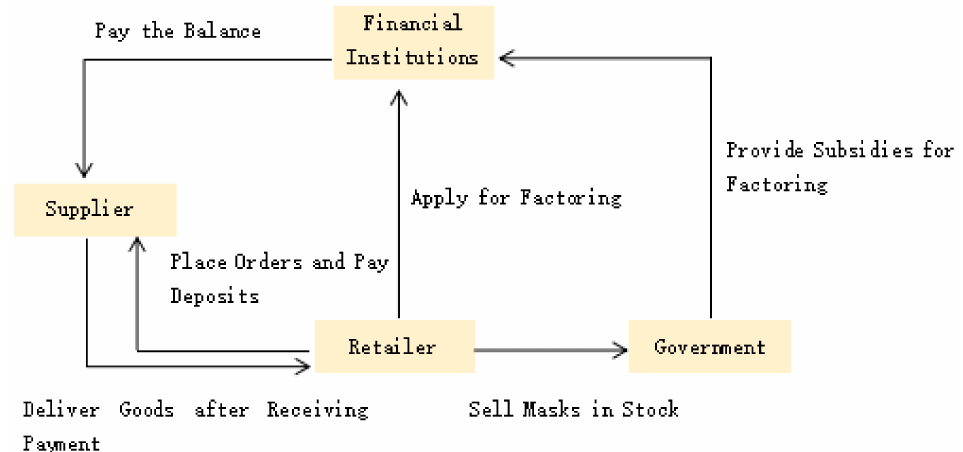
Figure 4. Financing model of the green supply chain for masks based on